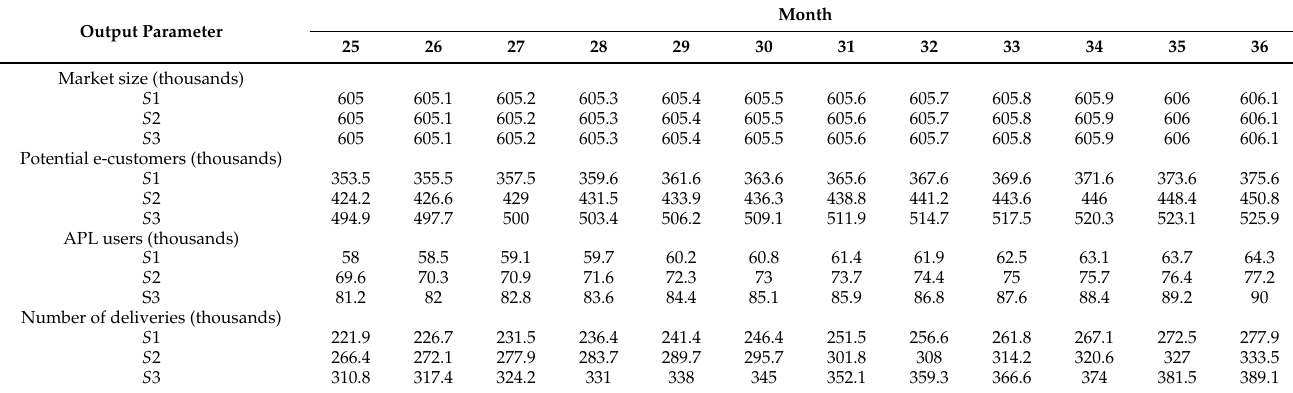
Table A3. Results generated by the SDSM in the third